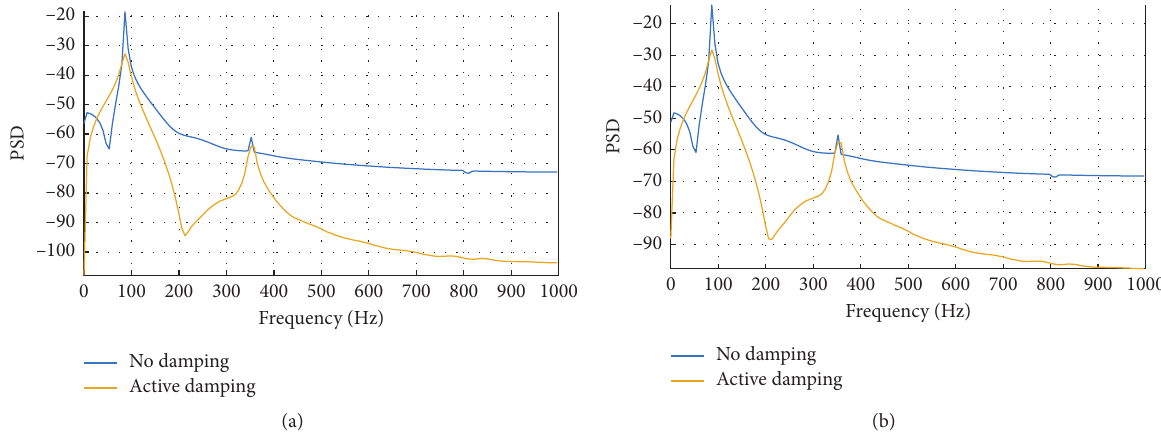
Figure 10: PSD of the first three modes of each link for the 1 st trajectory. (a) 1 st link. (b) 2 nd